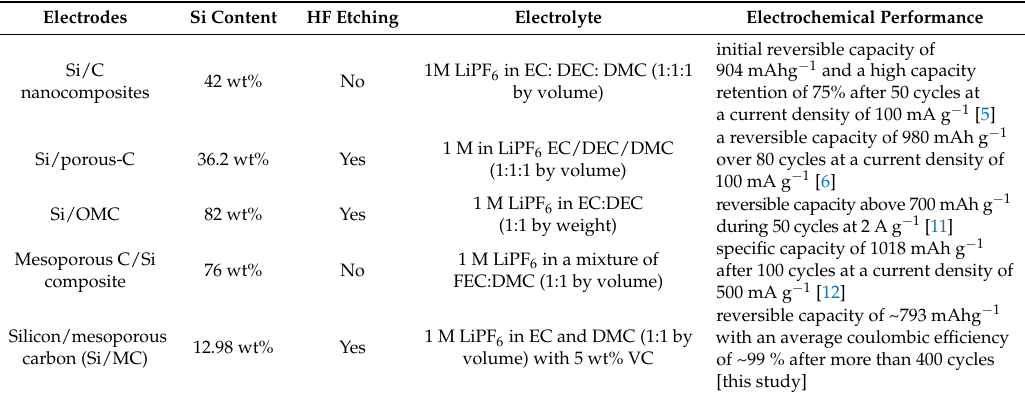
Table 1. Overview of literature data on Si/carbon (Si/C) materials prepared from phenolic resin as a carbon source: Si content, hydrofluoric acid (HF) etching, electrolyte, and electrochemical performance.